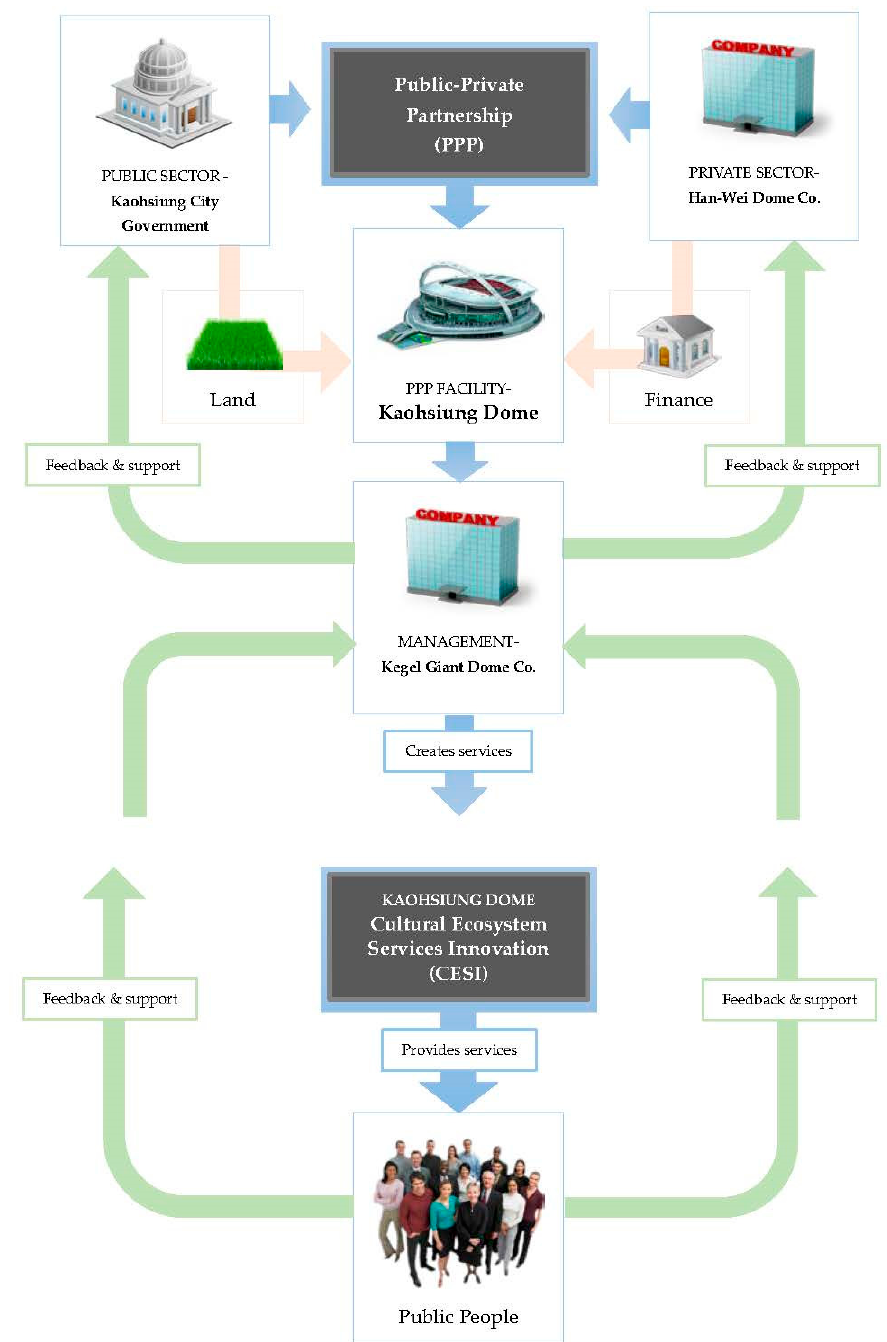
Figure 9. Public-private partnership—cultural ecosystem services innovation model (PPP-CESI model) of Kaohsiung